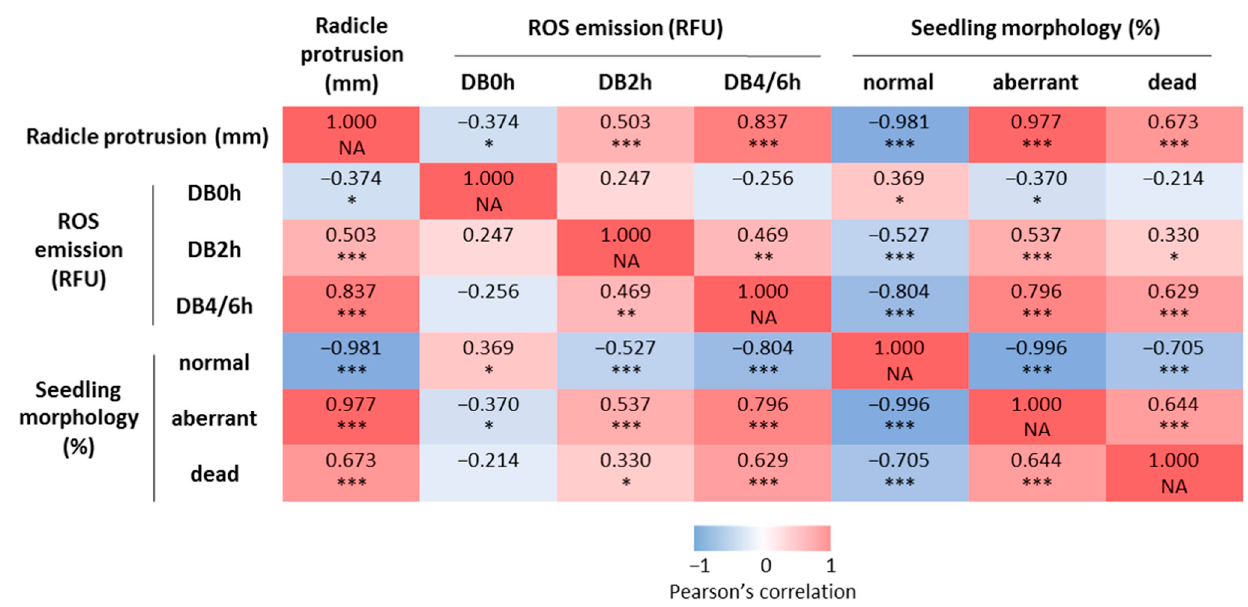
Figure 6. Correlation analysis carried out between the radicle protrusion length before dry-back, the ROS emission during dry-back and seedling morphology. DB0h, ROS levels before dry-back; DB2h, ROS levels after 2 h dry-back; DB4/6h, ROS levels at the endpoint of dry-back. The Pearson’s correlation coefficients are indicated. The significance of the Pearson’s correlation is shown by asterisks (‘*’ p < 0.05, ‘**’ p < 0.01, ‘***’ p < 0.001). NA, not applicable.